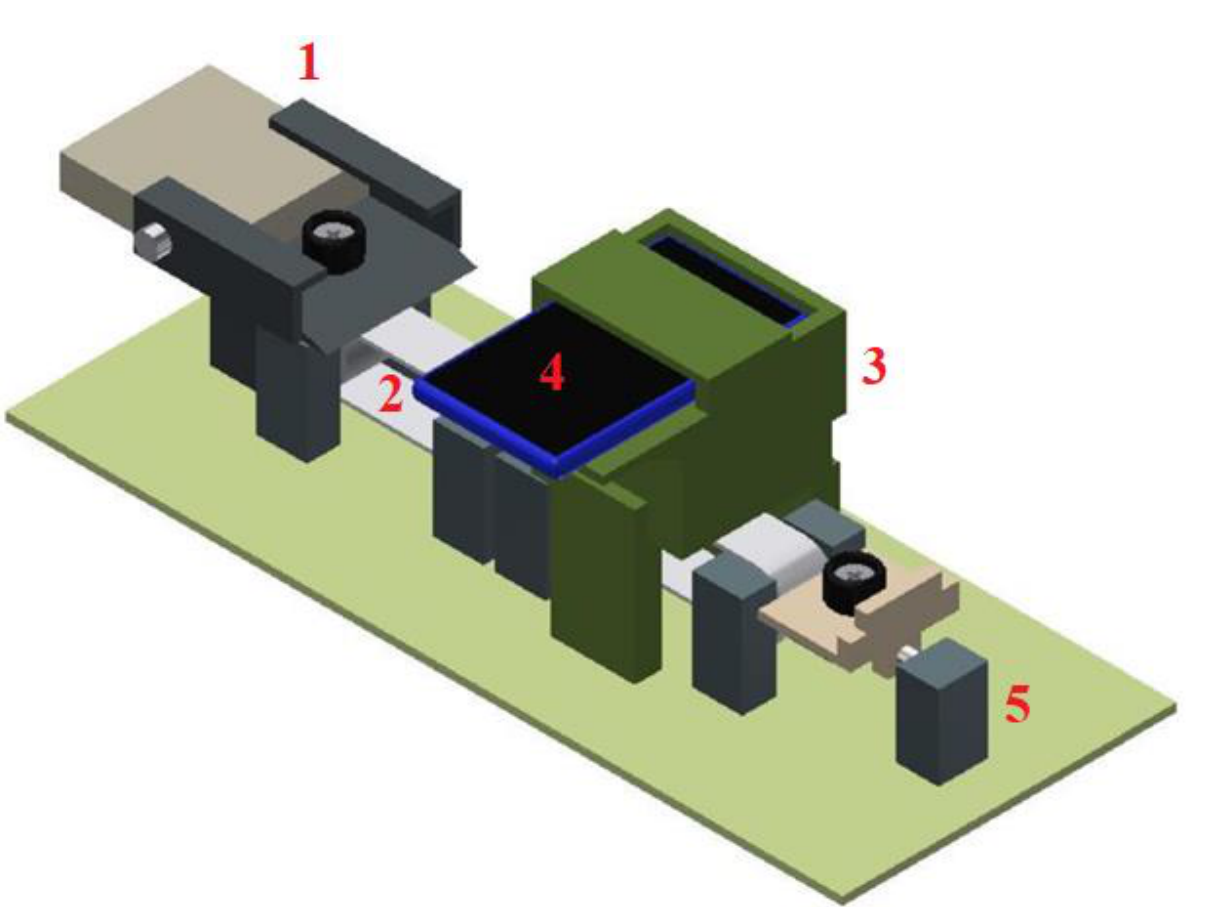
Figure 1. Design of the production line in Inventor: 1 — loading slider, 2 — conveyor belt, 3 — camera stand in connection with the camera tunnel, 4 — mobile, 5 — sorting mechanism.